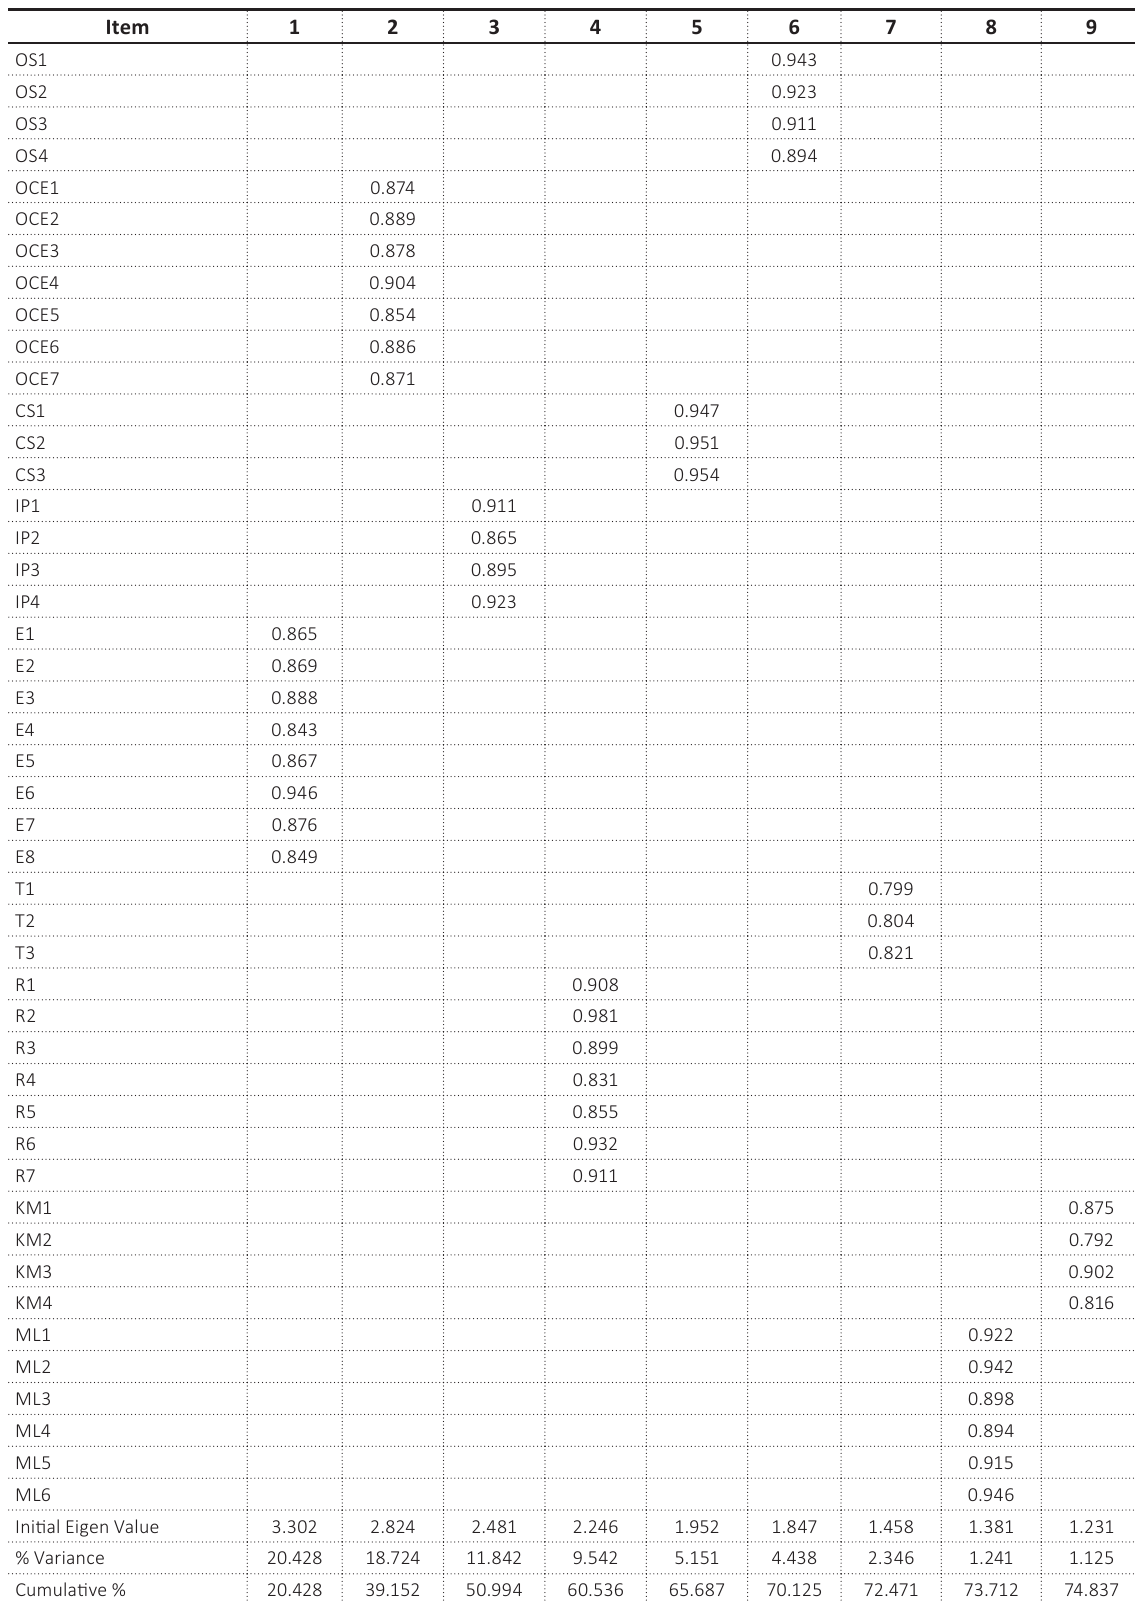
Source: Primary Data